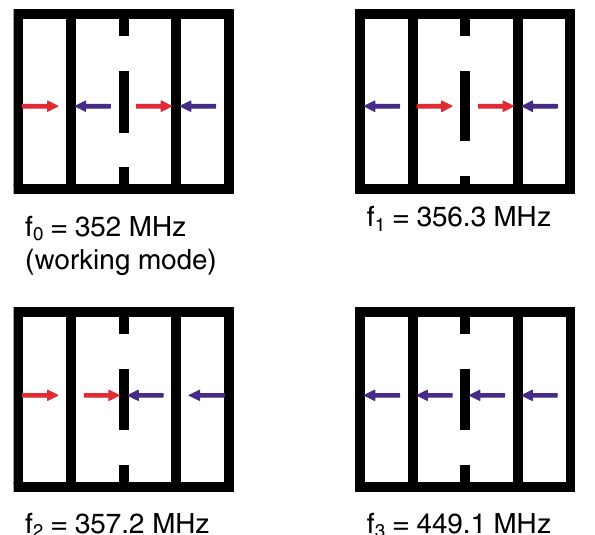
FIG. 9. (Color) Schematic representation of the first four fre- quency modes of the ladder structure.